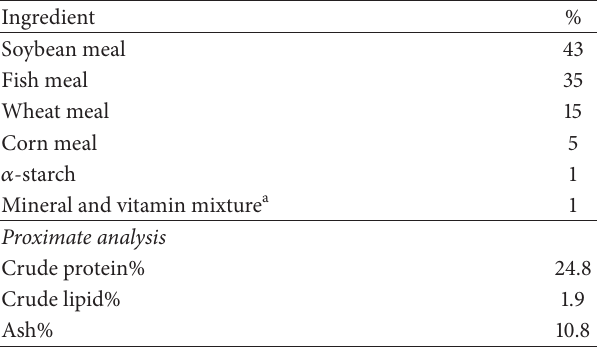
Table 2: Ingredient and chemical proximate composition of basic diet (% dry